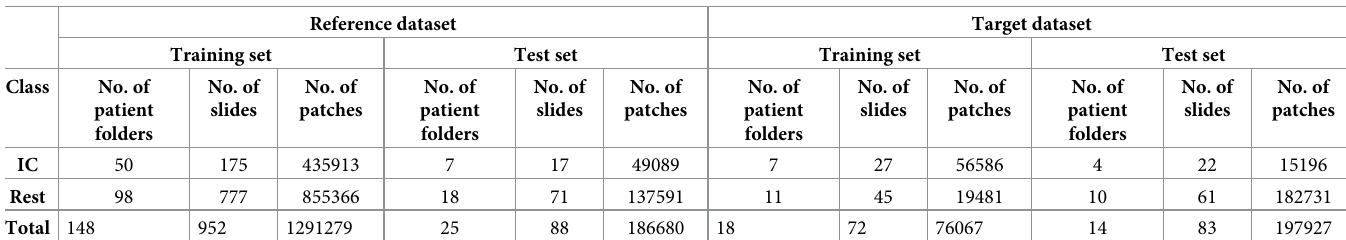
Table 2. Data set